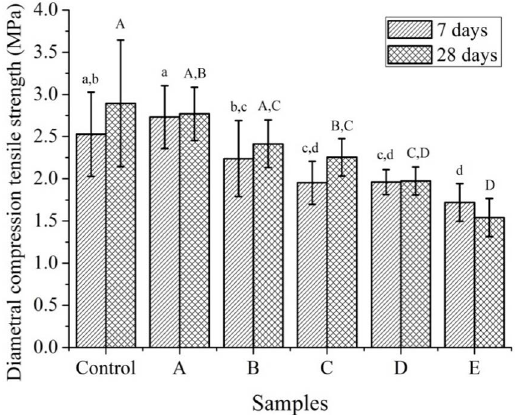
Figure 9. Result of tensile strength with diametrical compression in mortars, in the hardened state of 7 and 28 days.